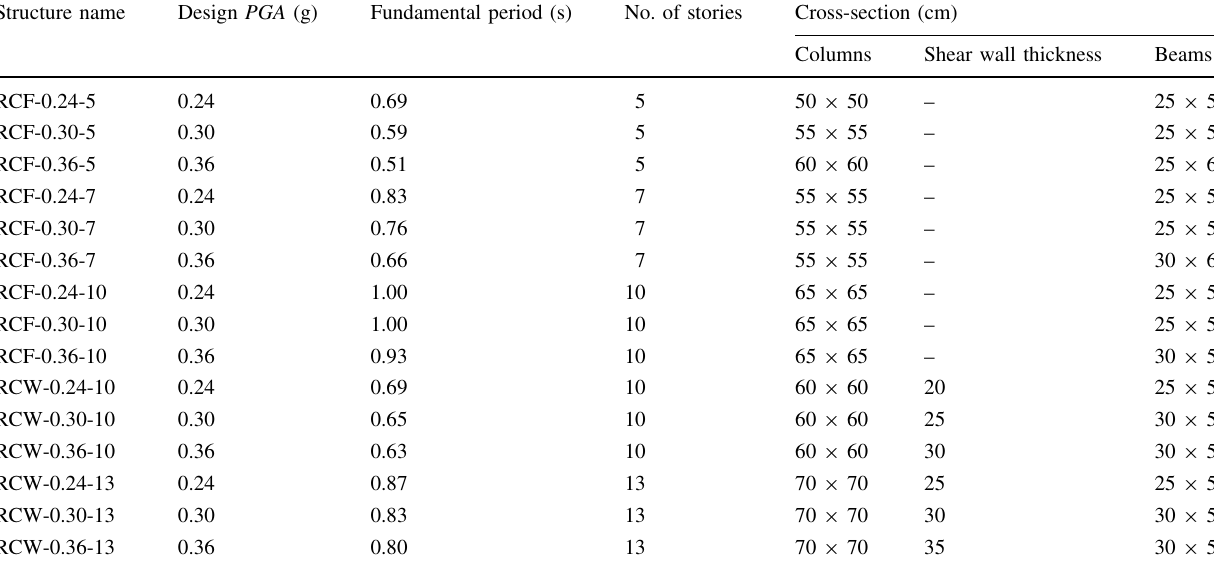
Table 1 Characteristics of the analyzed 15 reinforced concrete (RC) structures in Bucharest, Romania